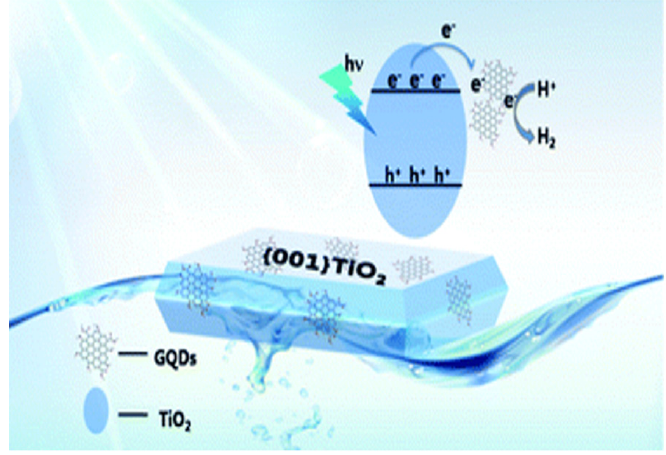
Figure 29. Schematic representation of 001-facet TiO 2 -GQD nanocomposites. Figure 29 reprinted from [133] with permission from The Royal Society of Chemistry.